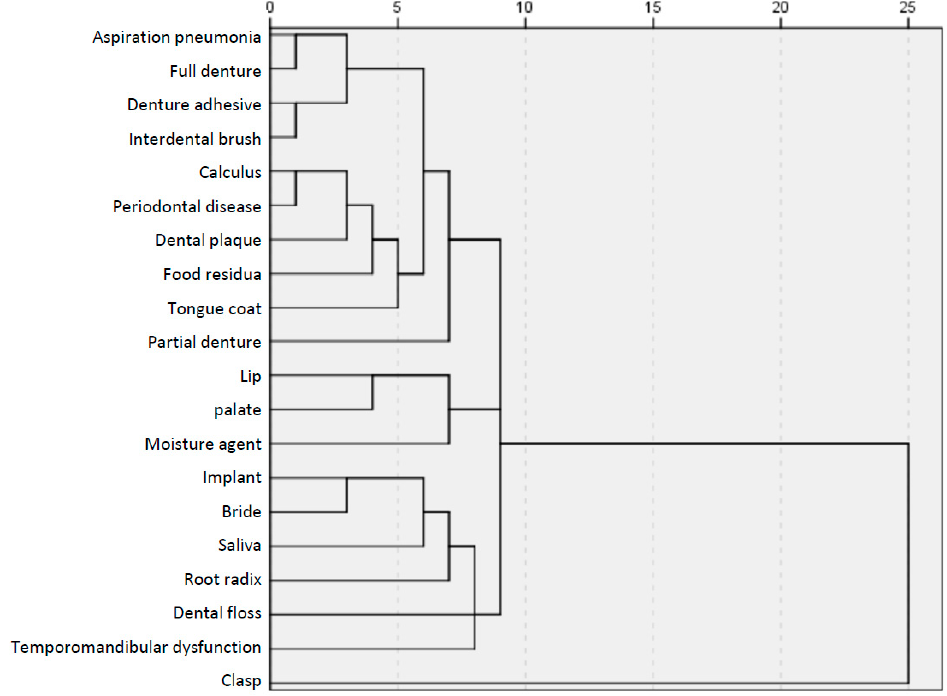
Figure 3. Dendrogram of 20 dental terms by hierarchical cluster analysis.